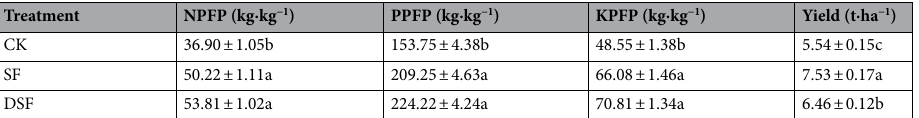
Table 4. Partial factor productivity of applied fertilizer (PFP) and grain yield of different fertilization modes of slow-release fertilizer. NPFP is the partial factor productivity of applied nitrogen fertilizer, PPFP is the partial factor productivity of applied phosphate fertilizer, KPFP is the partial factor productivity of applied potash fertilizer; Mean ± SE sharing a common letter within a column don’t differ significantly at p < 0.05 according to Tukey’s multiple comparisons